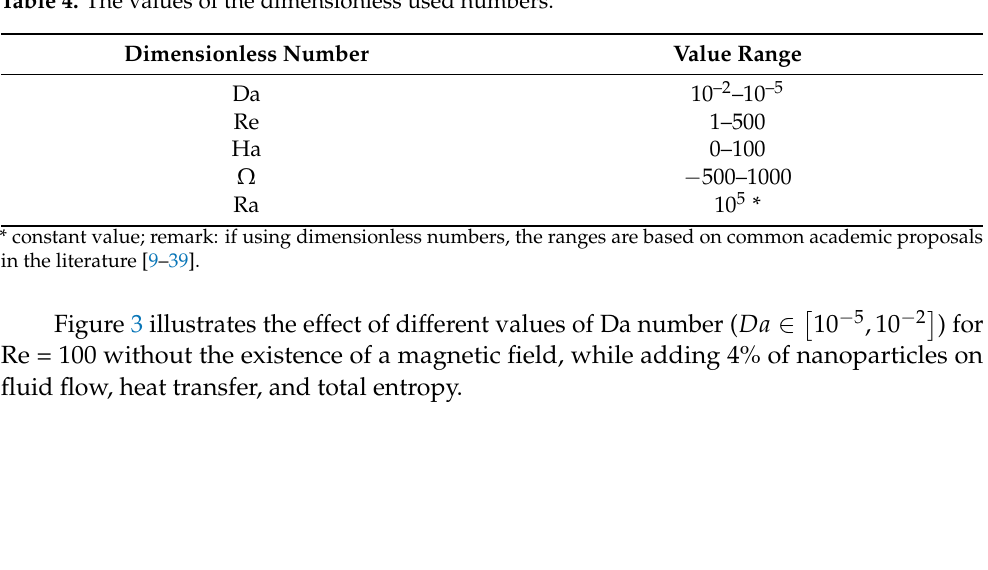
Table 4. The values of the dimensionless used